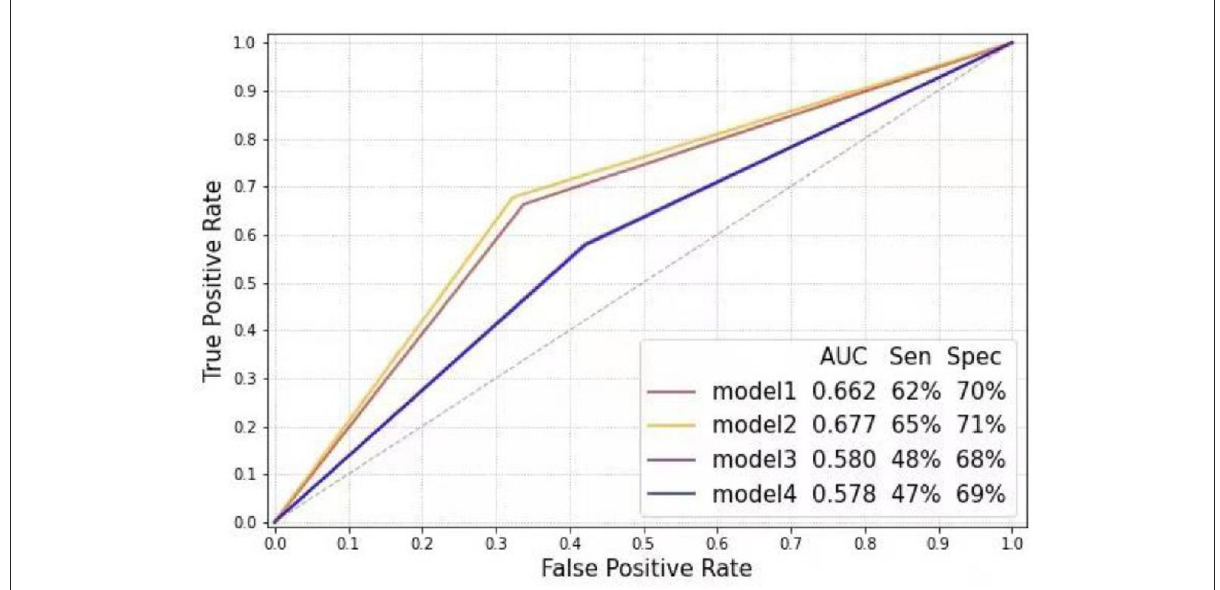
FIGURE4 Receiver operating characteristic curve analysis of different models according to gender and relative wall thickness (Model 1: Control-M vs. concentric LVH-M; Model 2: Control-M vs. eccentric LVH-M; Model 3: Control-F vs. concentric LVH-F; Model 4: Control-F vs. eccentric LVH-F). LVH-F, female patients with left ventricular hypertrophy; LVH-M, male patients with left ventricular hypertrophy; Control-F, female patients in control group; Control-M, male patients in control